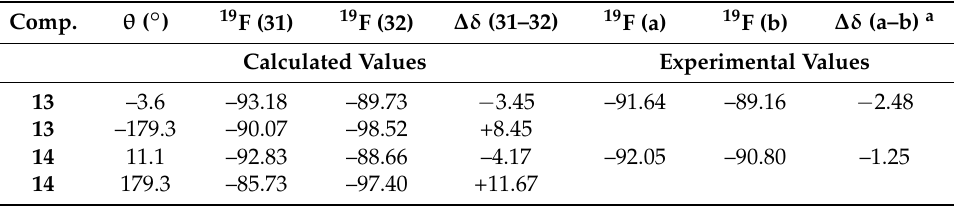
Table 1. Calculated (gas phase) and experimental 19 F-NMR chemical shifts (CDCl 3 ).